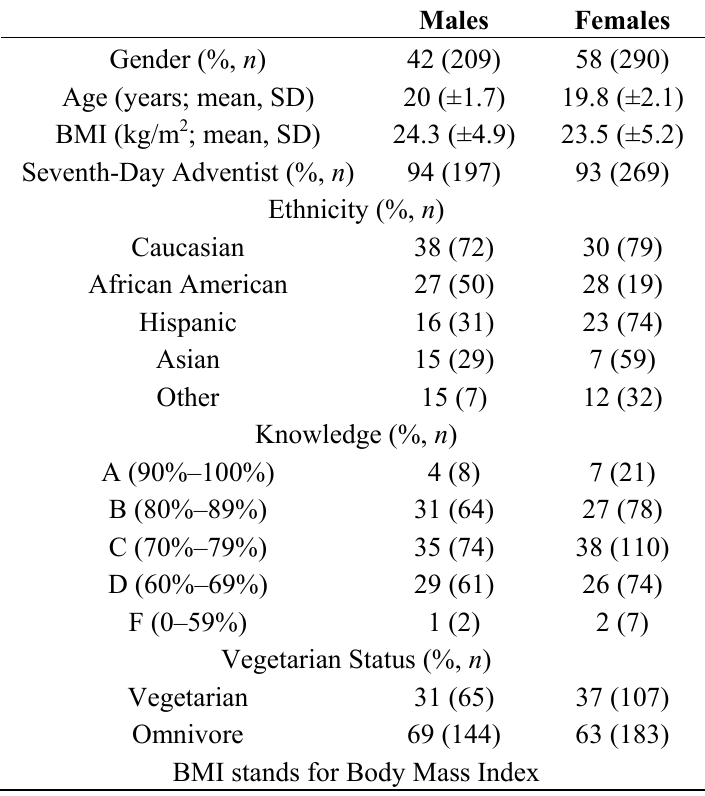
Table 1. Selected Characteristics of